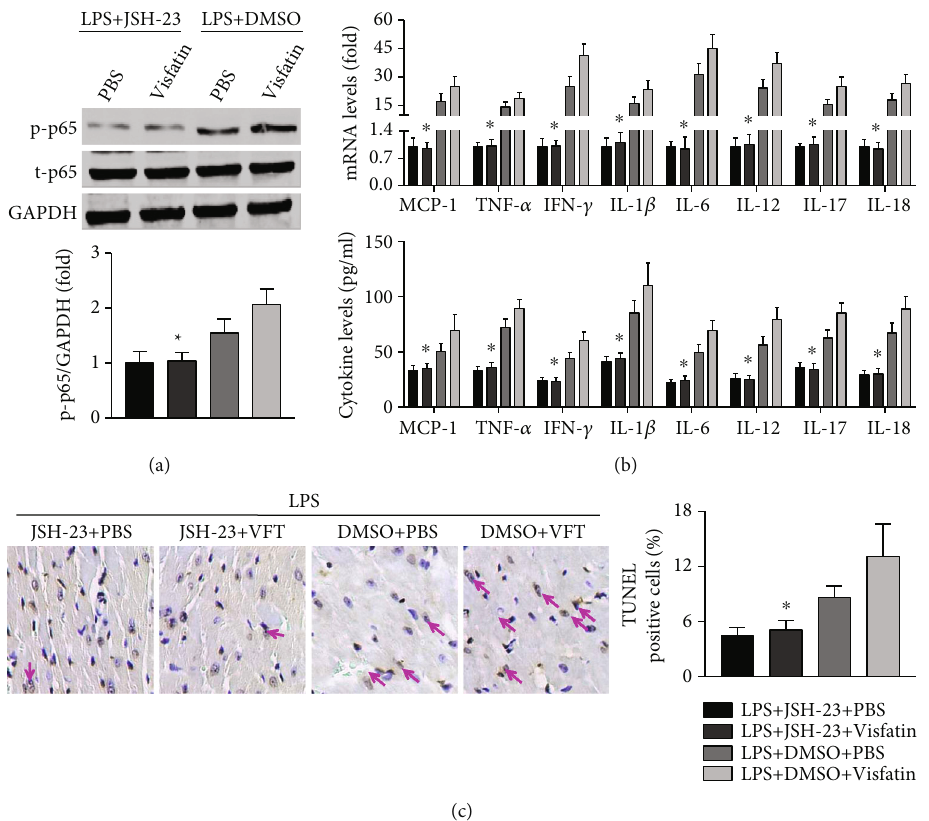
Figure 6: E ff ects of JSH-23 on cardiac in fl ammation and myocardial cell apoptosis. (a) Phosphorylation of NF- κ B p65 pathway components was detected. (b) In fl ammatory mediators in the heart and serum were examined. (c). The numbers of TUNEL-positive myocardial cells were quanti fi ed. N = 5 − 10 in each group. ∗ p < 0 : 05 vs. the LPS+DMSO+ VFT